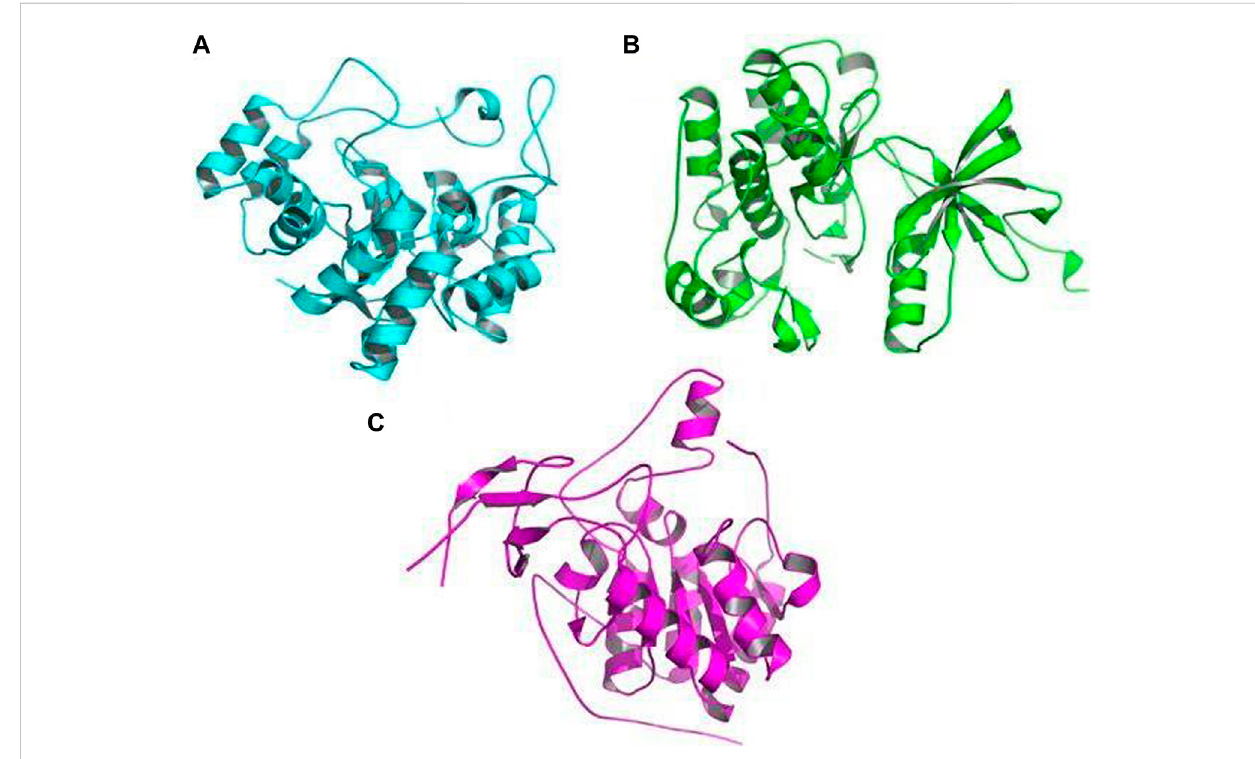
FIGURE 10 Crystal picture receptors: (A) aldose reductase (AR) (PDB ID: 1USO), (B) tyrosine kinase (TK) (PDB ID: 1IR3), and (C) SIRT6 (PDB ID: 3K35).